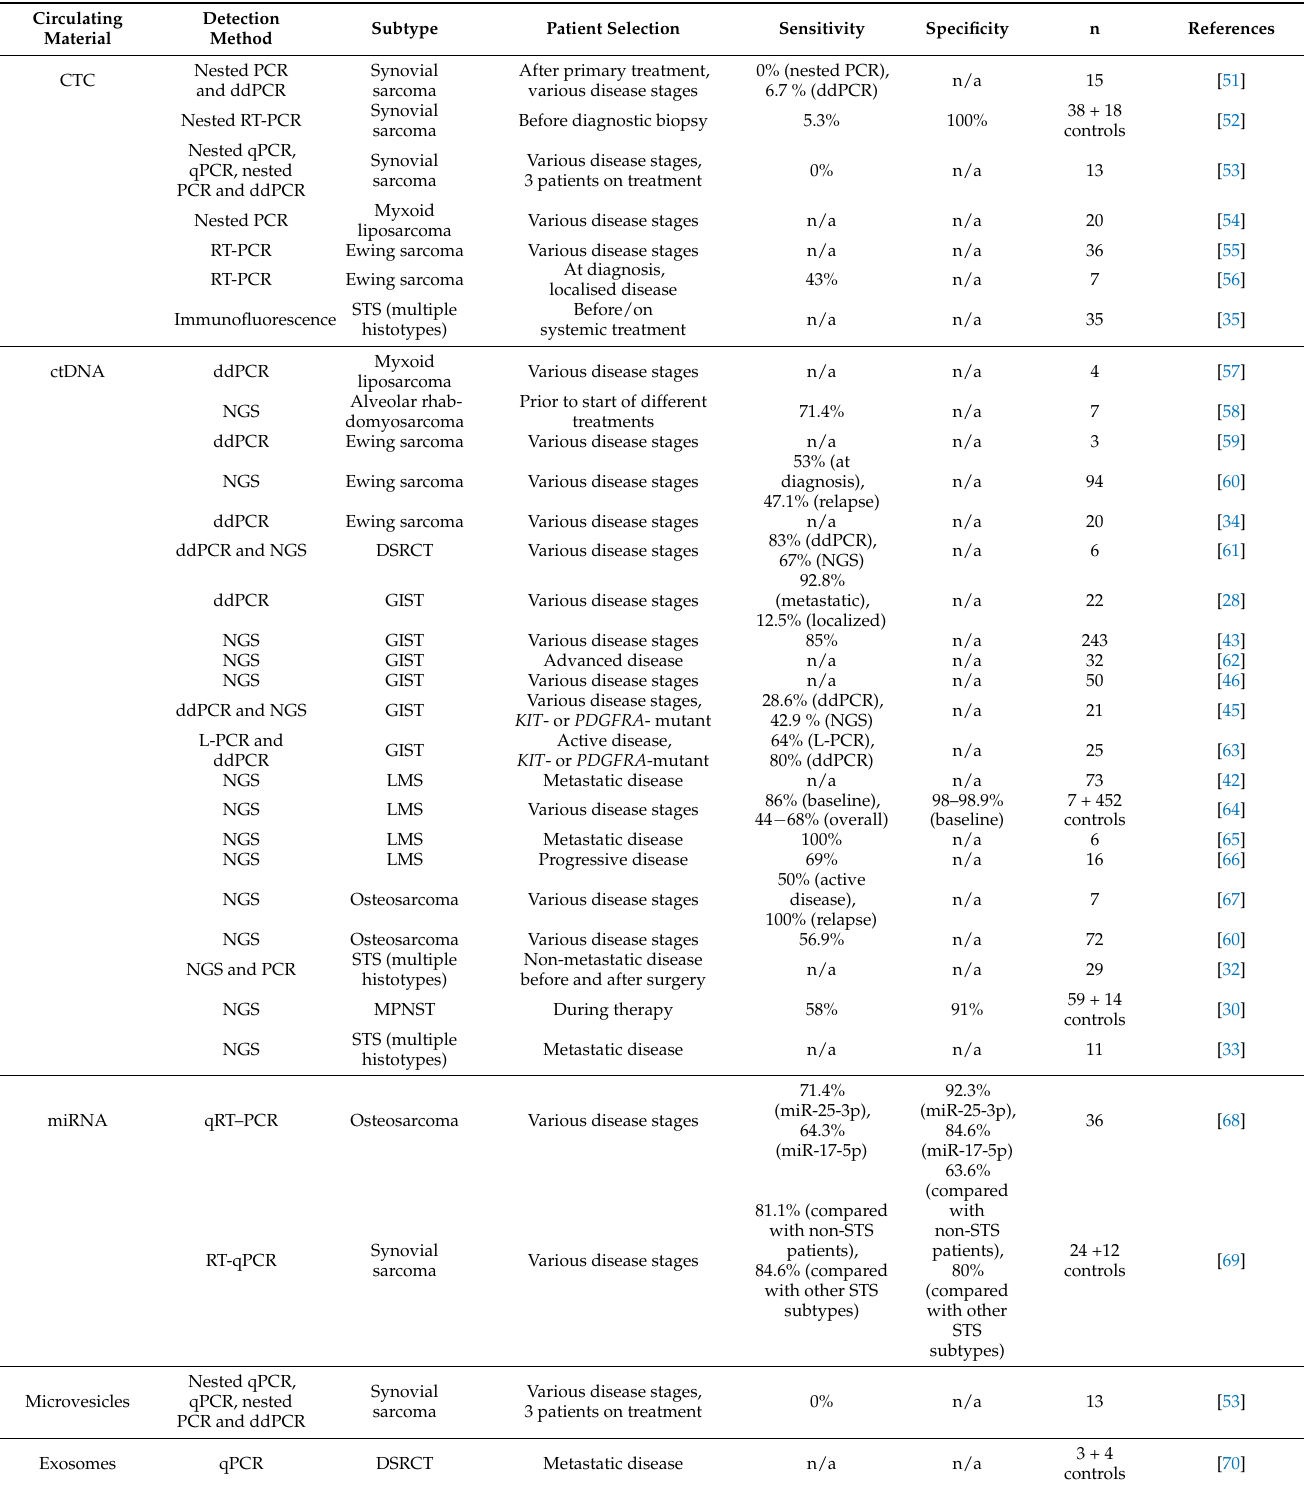
Table 2. Sensitivity and specificity rates of assays performed in sarcoma patients. Rates are either mentioned in the papers or calculated based on provided data. PCR: polymerase chain reaction; ddPCR: digital droplet PCR; RT-PCR: reverse transcription PCR; qPCR: quantitative PCR; NGS: next generation sequencing; L-PCR: ligation PCR; STS: soft tissue sarcoma; DSRCT: desmoplastic small round cell tumor; GIST: gastrointestinal stromal tumor; LMS: leiomyosarcoma; MPNST: malignant peripheral nerve sheath